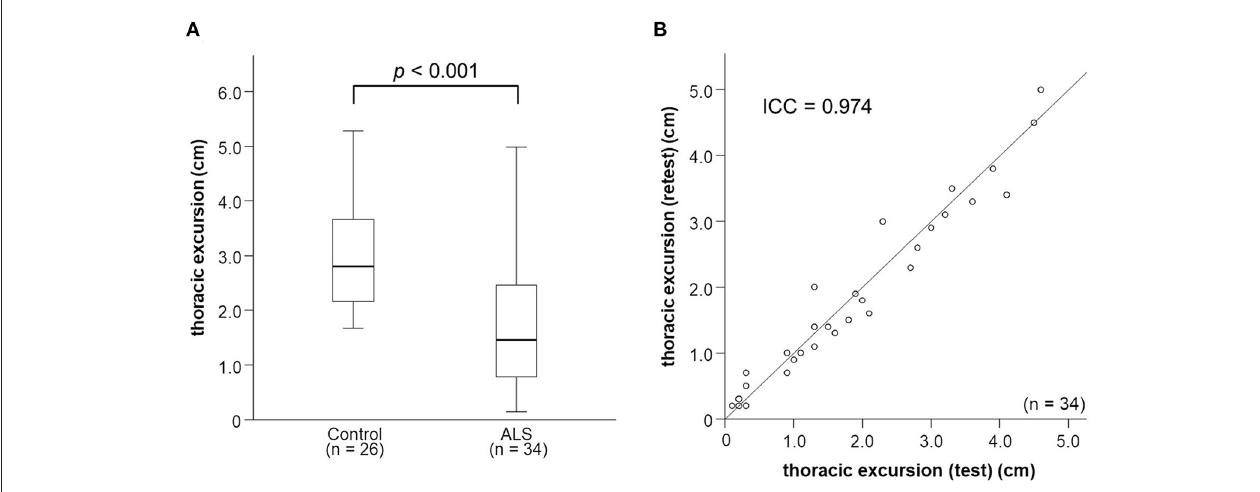
FIGURE 2 | Thoracic excursion in patients with ALS. (A) The values of thoracic excursion in patients with ALS are significantly smaller than those in control patients. (B) Thoracic excursion measurement shows excellent test-retest reliability. ALS, amyotrophic lateral